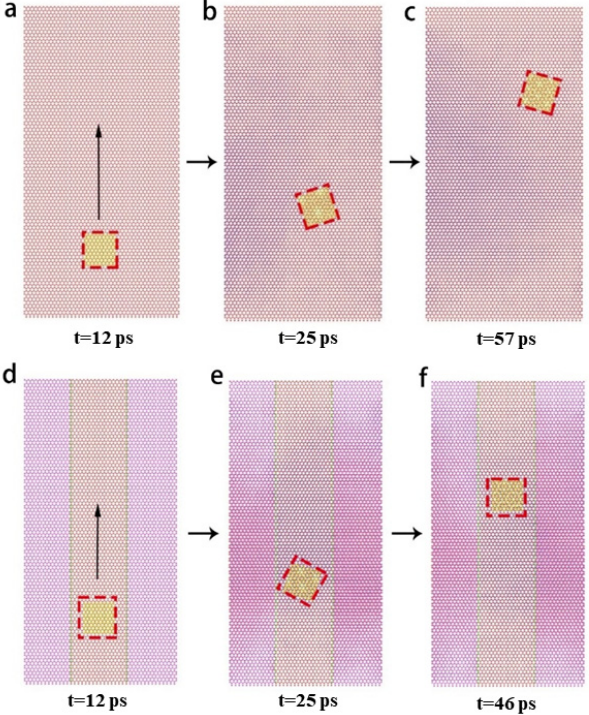
Figure 3. The snapshots of the movement of the nanoflakes. ( a – c ) Graphene nanoflake moved in the normal model. ( d – f ) Graphene nanoflake moved in the channel model.